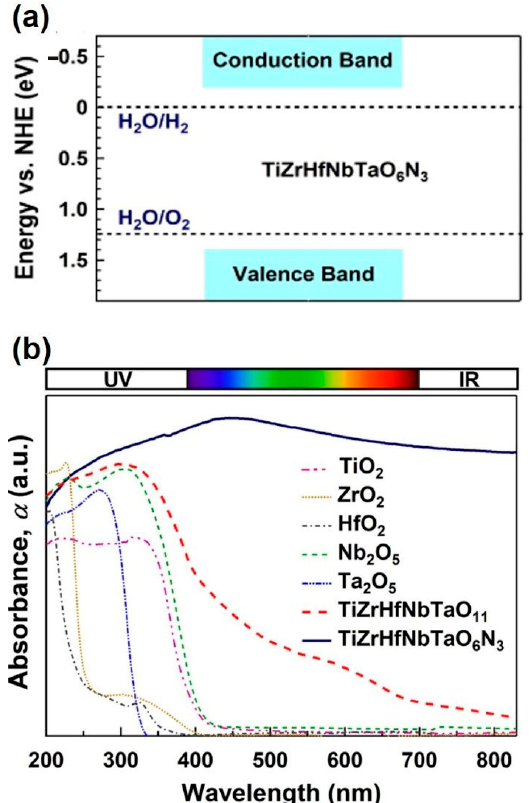
Figure 8. ( a ) Band structure compared with required potentials for water splitting, and ( b ) light absorbance compared with binary and high-entropy oxides for nanograined dual-phase high-entropy oxynitride TiZrHfNbTaO 6 N 3 , synthesized by high-pressure torsion followed by high-temperature oxidation and nitriding, reproduced from [77], with permission from ROYAL SOCIETY OF CHEMISTRY, 2021.